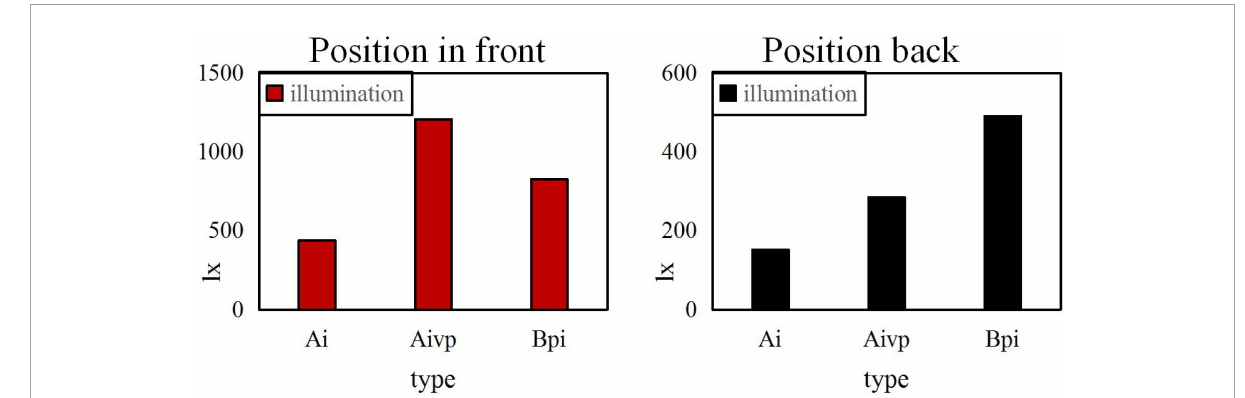
FIGURE7 Illumination comparison before and after the position when the uniformity U0 is 0.4.